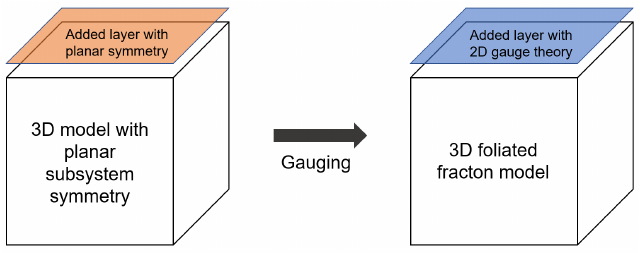
Figure 1: Correspondence of foliation structure in 3D systems with planar subsystem symmetry and 3D foliated fracton